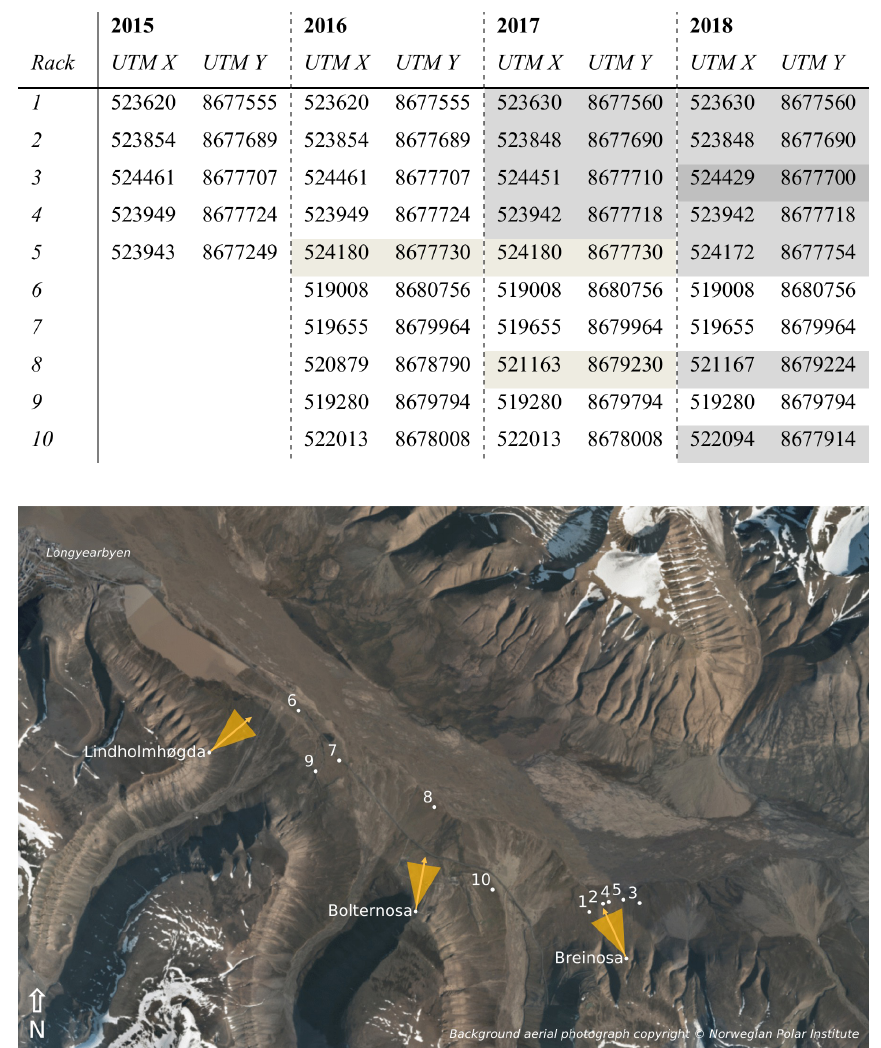
Figure 1. Locations of the instrumentation in the valley of Adventdalen during the 2018 field season (white dots). The racks are labelled with their respective number, while the landscape cameras are labelled according to the nearby mountain peaks. The yellow arrows show the direction in which the landscape cameras are pointed, while the triangles indicate their approximate viewing angle. The background image is a composite of several orthographic photographs taken by the Norwegian Polar Institute in July